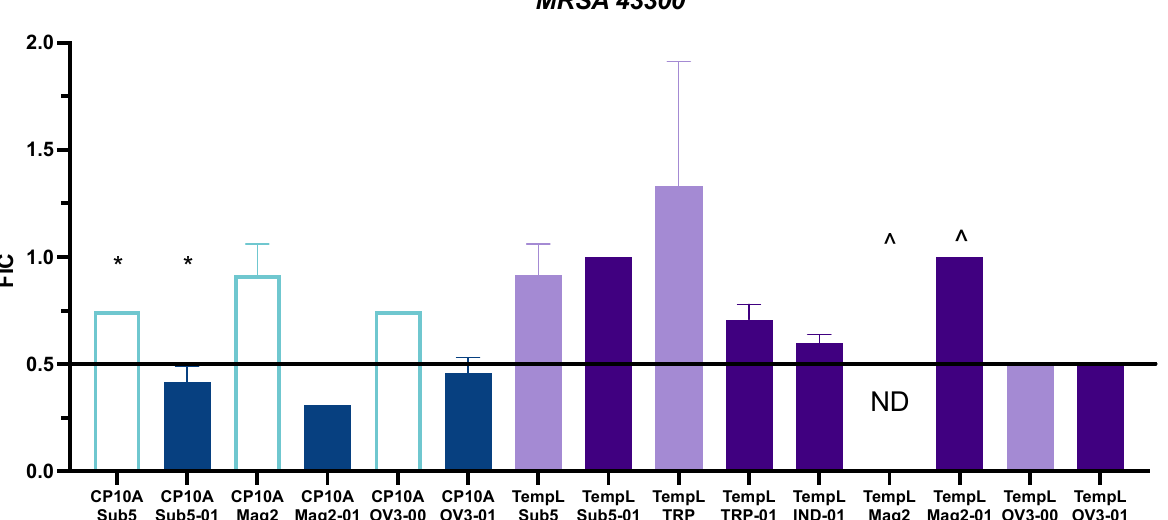
Figure 4. Representation of FIC values for interactions of CP10A (blue) and TempL (purple) in MRSA 43300. ATCUN-containing derivatives are represented as dark blue or dark purple and parental peptides are represented as light blue or light purple. The line at 0.5 represents the threshold for synergy. For data marked (^), Mag2-01 had no detectable MIC in MRSA 43300, and the FIC value was calculated from the lowest detectable concentration on the FIC plate. Mag2 parental activity was not determined (ND). Error is reported as the standard deviation of the mean. Starred data (*) are previously reported data from reference [11] for comparison.